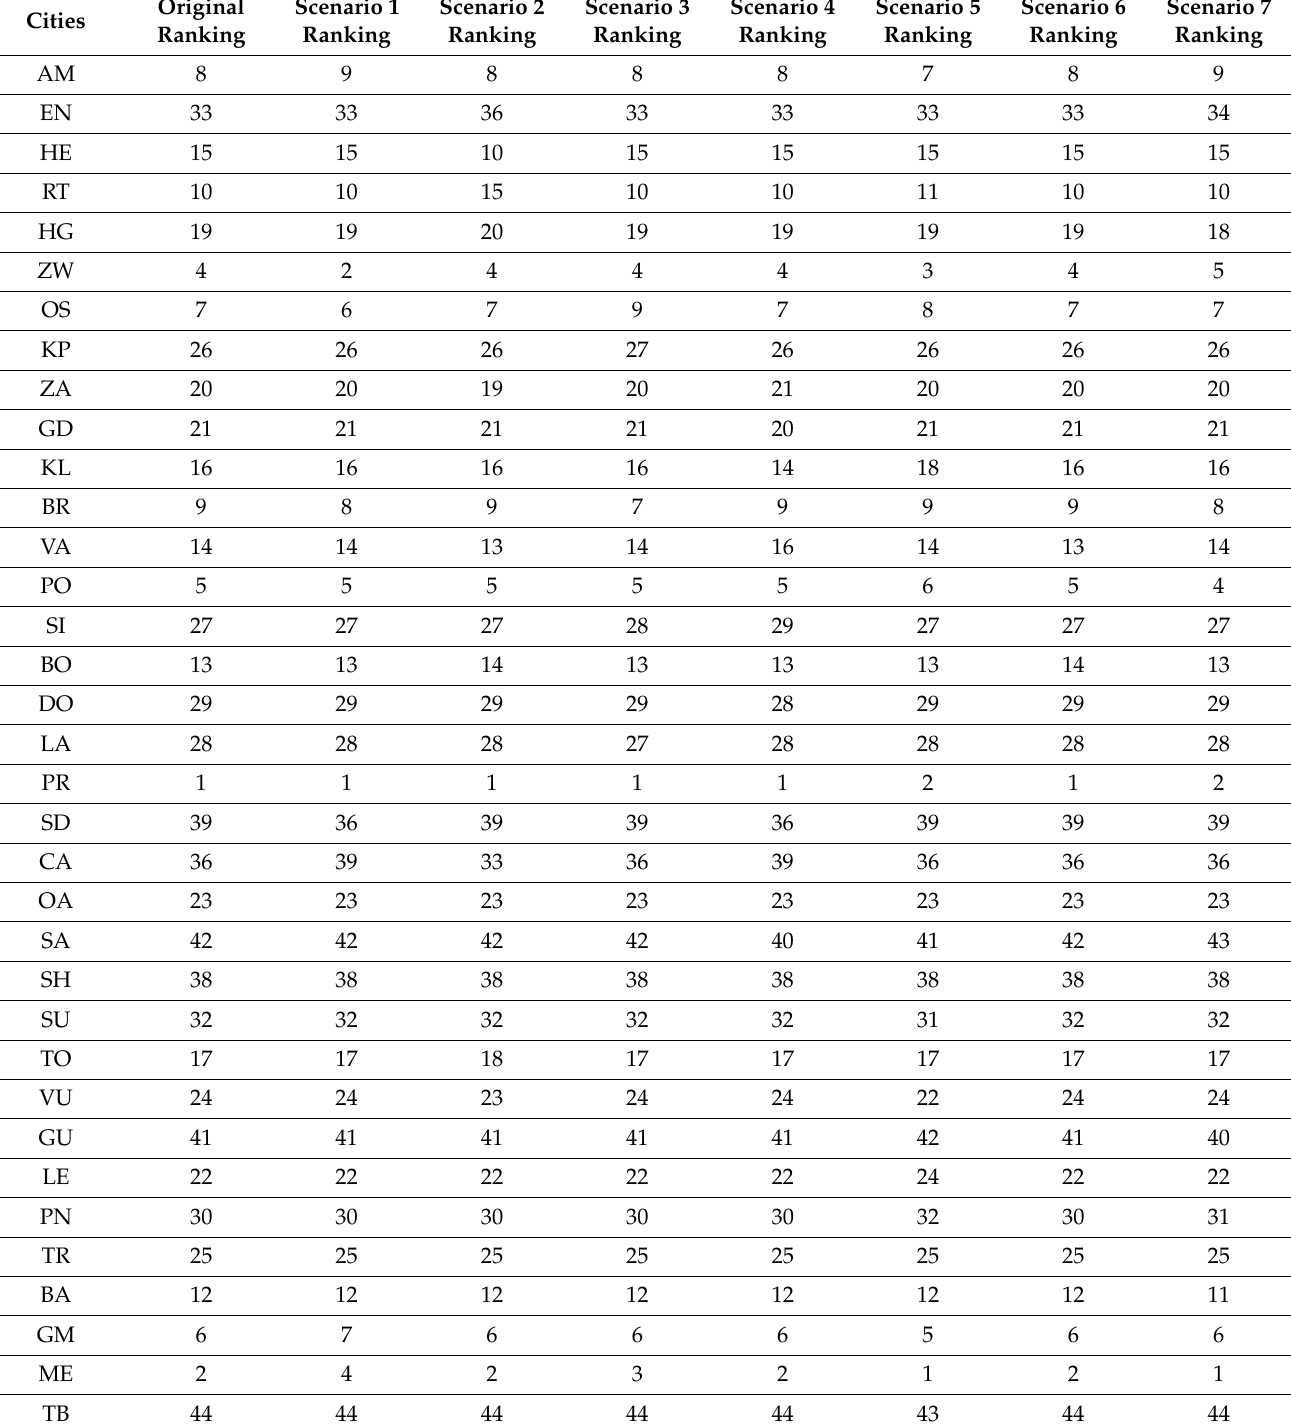
Table 7. The rank of the cities in various